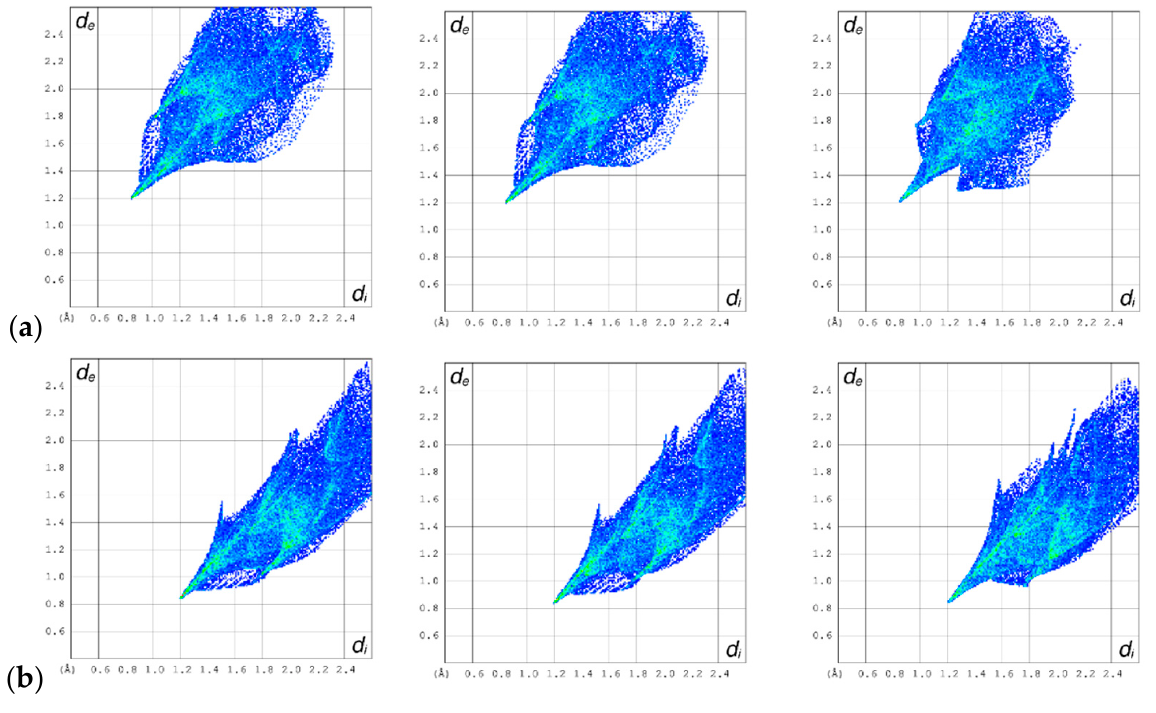
Figure 4. ( a ) the fingerprint plots of the cations in I, II, and III from left to right; ( b ) fingerprint plots of the anions in I, II, and III in the same order as the cations.